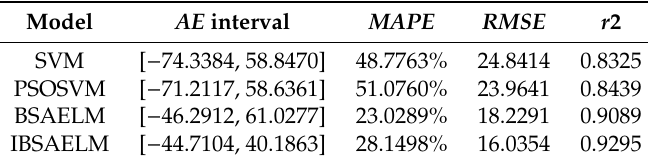
Figure 7. AE error of two-day traffic flow sequence. Table 4. Evaluation results of two-day traffic flow forecasting.